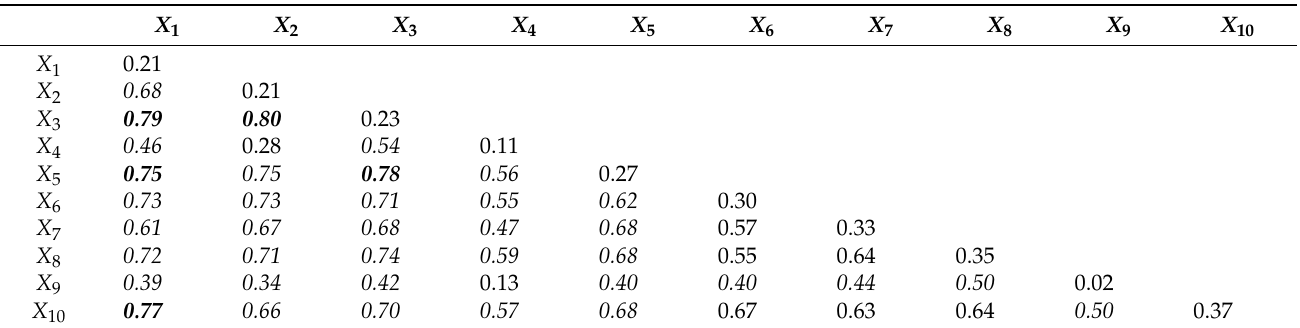
Table 5. Interaction detector of village facilities digitalization index.